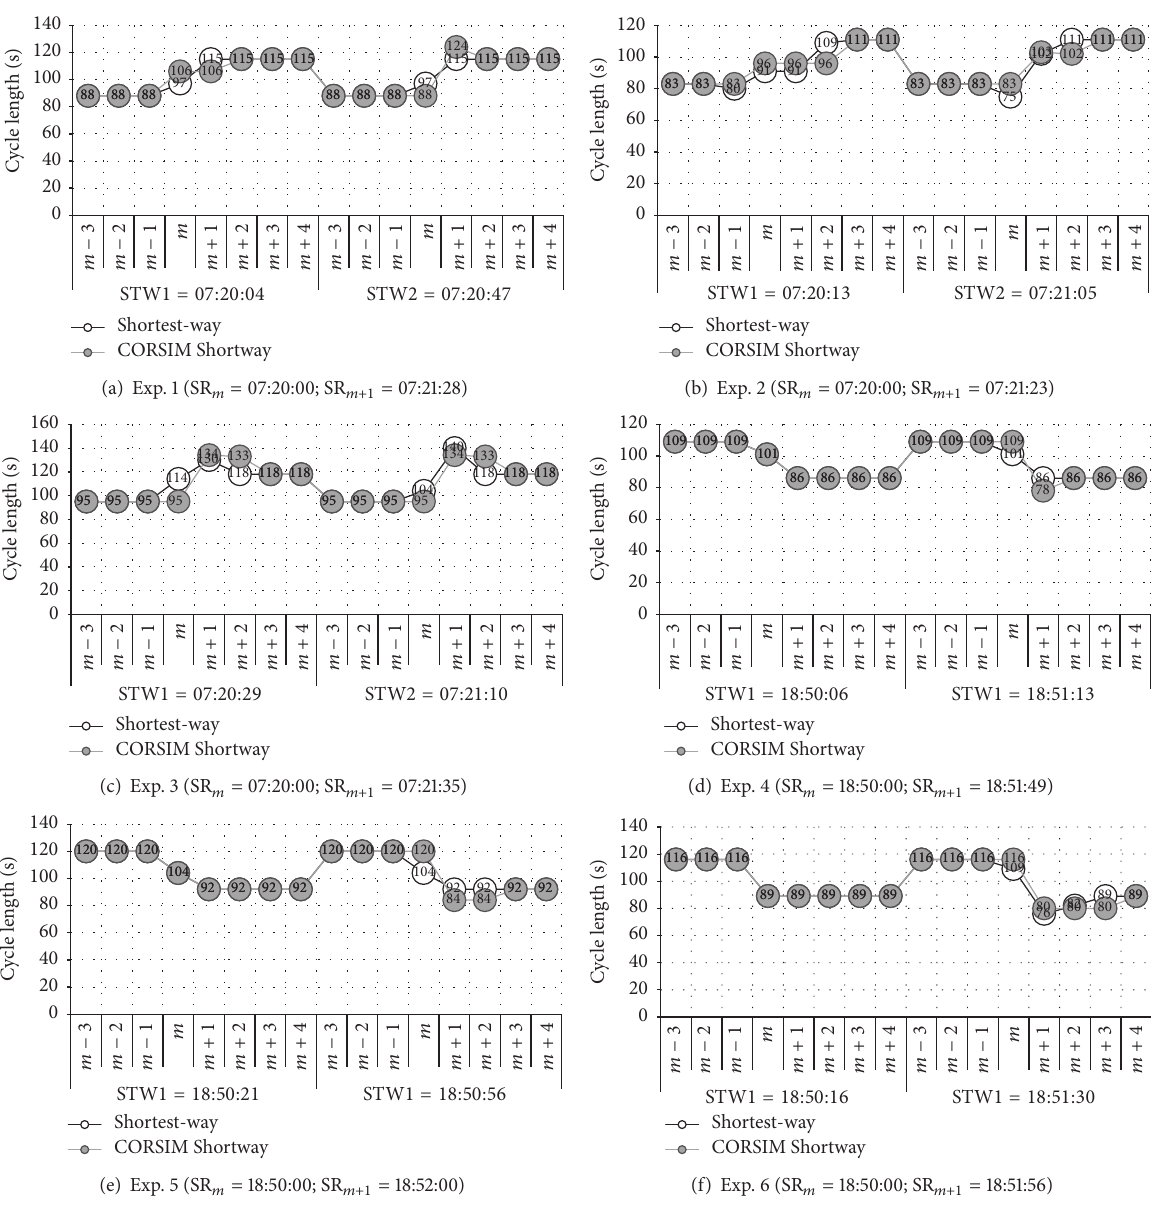
Figure 5: Cycle lengths between SR 𝑚−3 and SR 𝑚+4